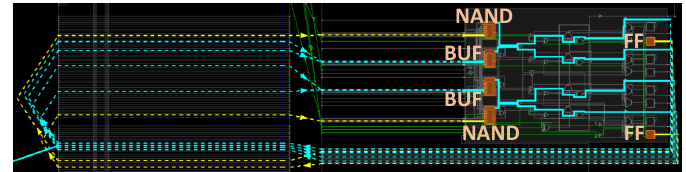
Figure 13. Place and route for 1-bit PicoPUF [37] in the proposed MMPUF design.